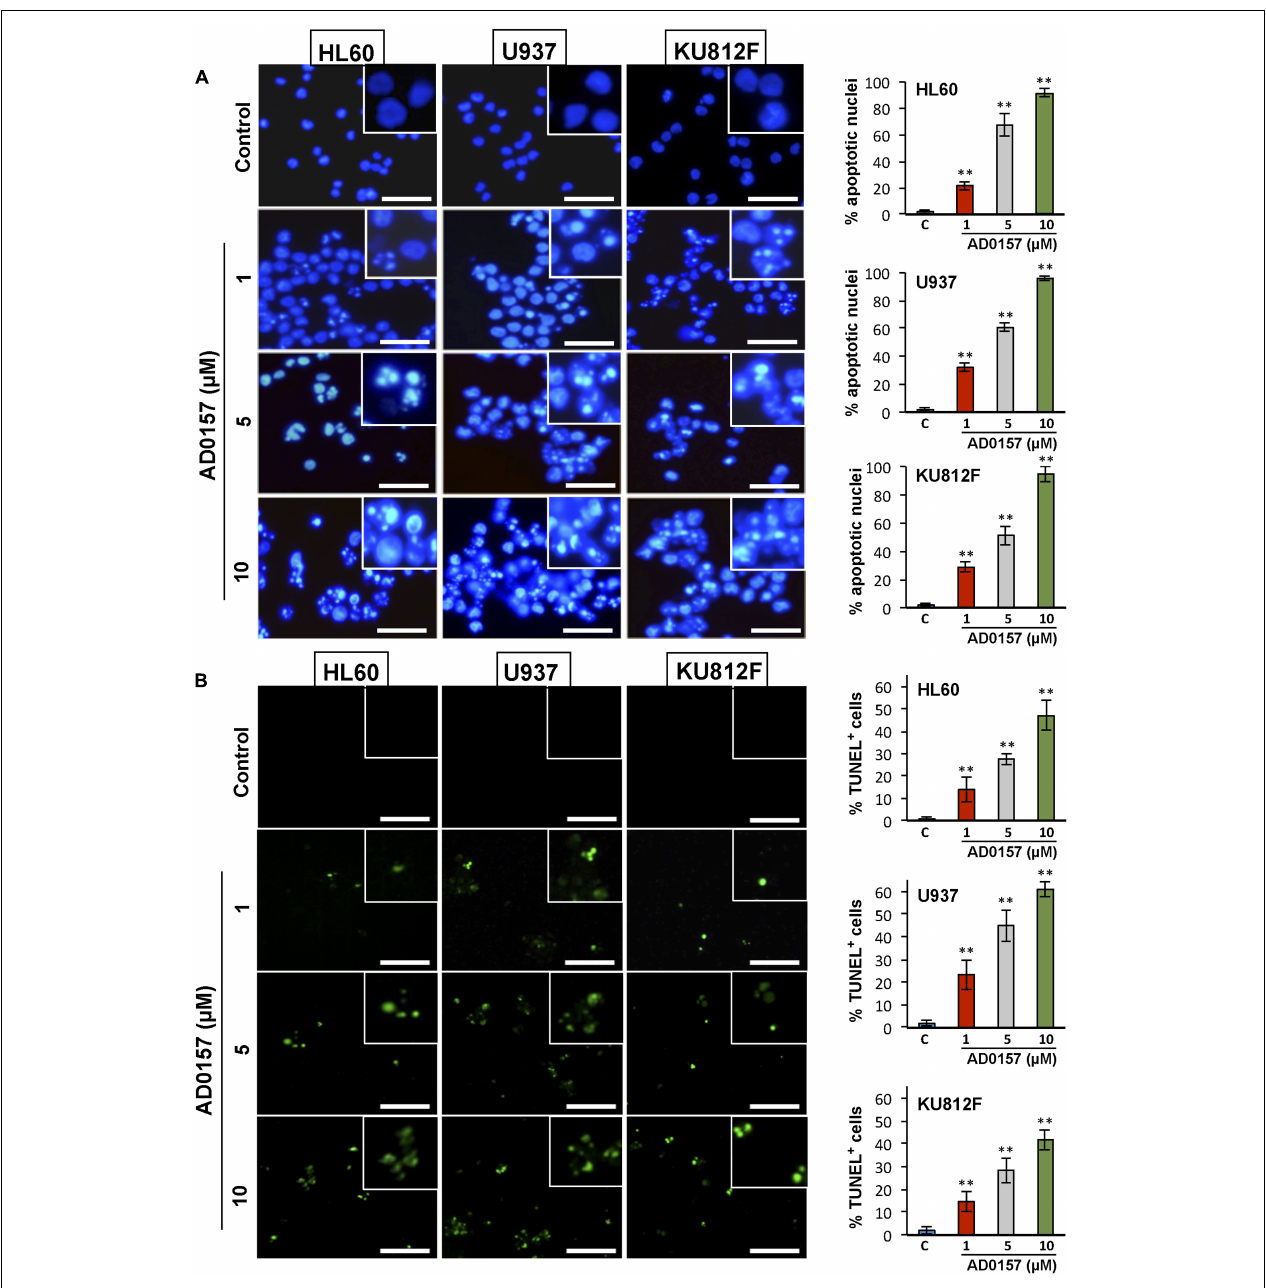
FIGURE 2 | AD0157 induces chromatin condensation and DNA fragmentation in HL60, U937 and KU812F cells. (A) Effect of AD0157 on human myeloid cell morphology and chromatin condensation evaluated by Hoechst staining (bar = 50 µ m). Graphs represent the percentage of control and AD0157-treated cells showing condensed chromatin. Values are expressed as means ± SD of the counts evaluated in ten vision fields. ∗∗ p < 0.001 versus untreated cells. (B) Effect of AD0157 on DNA fragmentation assessed by TUNEL labeling (bar = 50 µ m). Graphs represent the percentage of control and AD0157-treated showing TUNEL positivity. Values are expressed as means ± SD of the counts evaluated in ten vision fields. ∗∗ p < 0.001 versus untreated